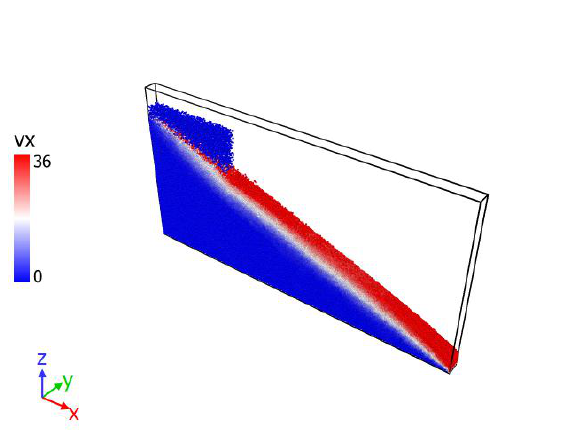
Figure 1. Snapshot of the simulation domain (orthogonal view). Colours of the grains are according to the x component of ve- locity, varying from blue to red with increasing magnitude. Co- ordinate axes are also suitably displayed. The snapshot has been generated using the open source visualisation tool OVITO [13].